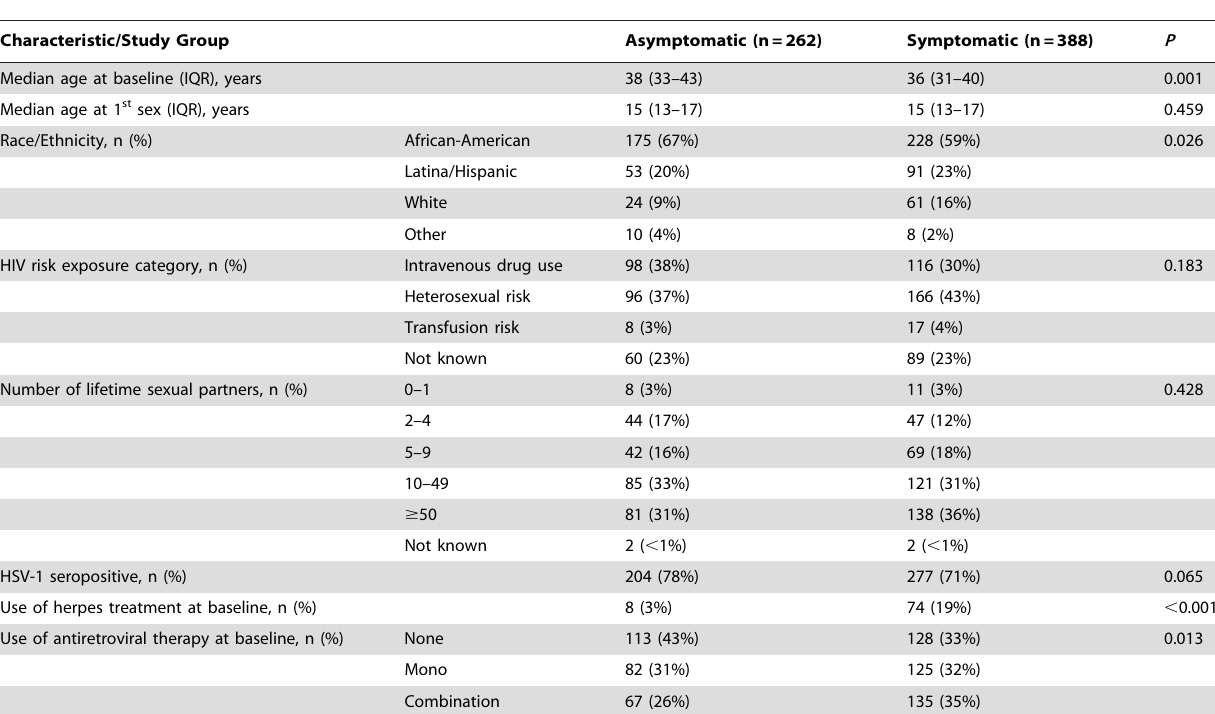
Table 1. Comparison of demographic, risk and clinical characteristics by study groups.